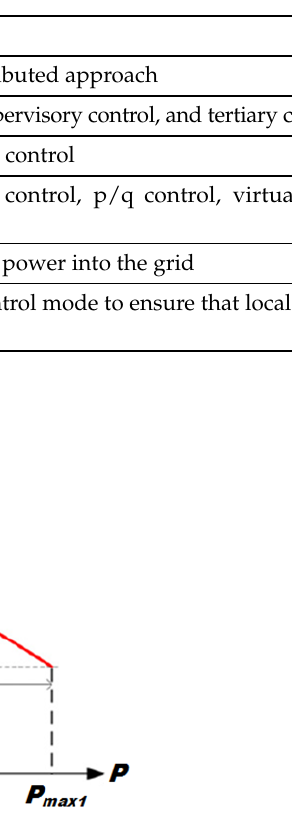
Figure 5. Control strategy for DC microgrid system using